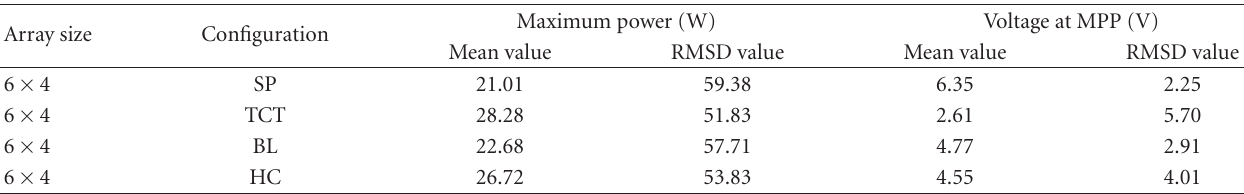
Table 6: Deviation of RMSD and mean value for 6 × 4 array when one bypass diode across the module and two bypass diodes across two groups of 18 cells in the